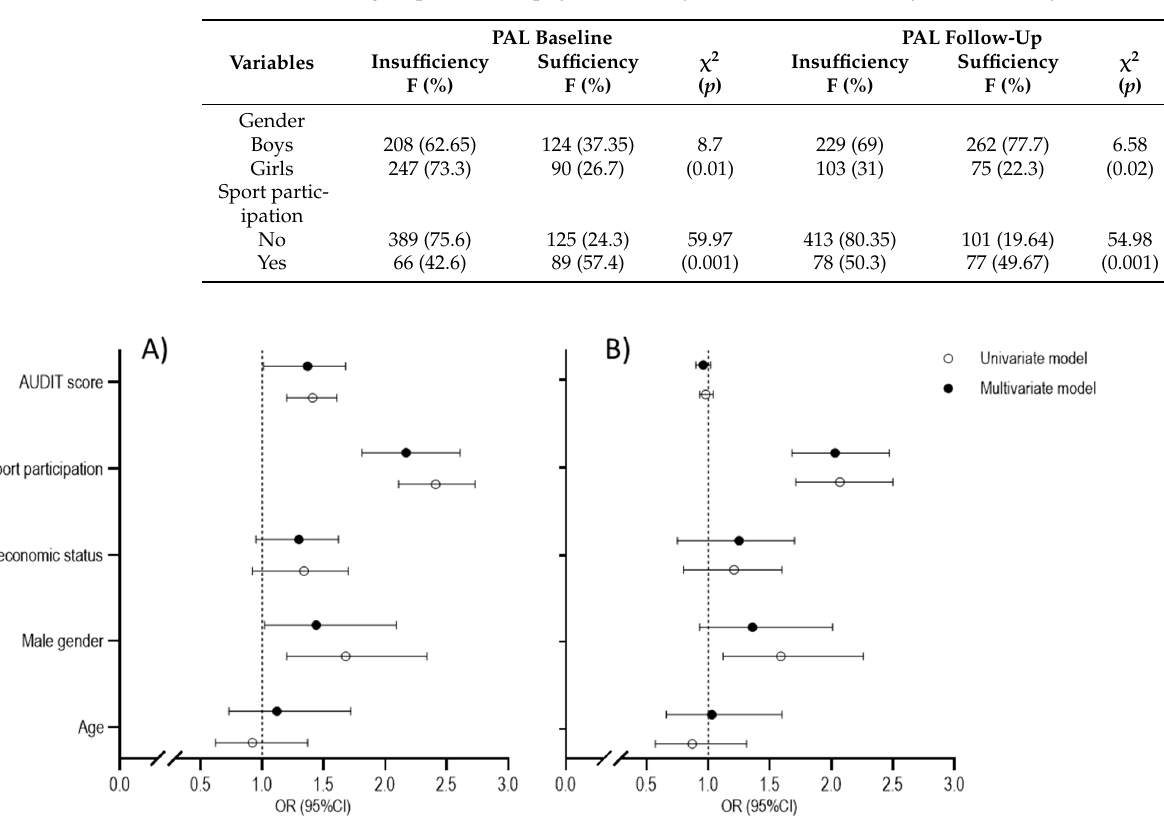
Figure 3. Results of the univariate and multivariate logistic regression calculations between predictors and criteria (PAL at baseline ( A ), and PAL at follow-up ( B )).